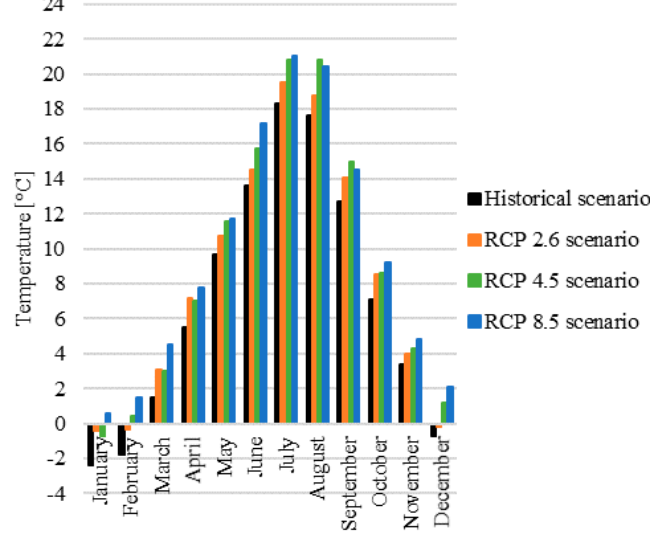
Figure 6. Mean monthly temperature at point B provided by the CORDEX experiment.